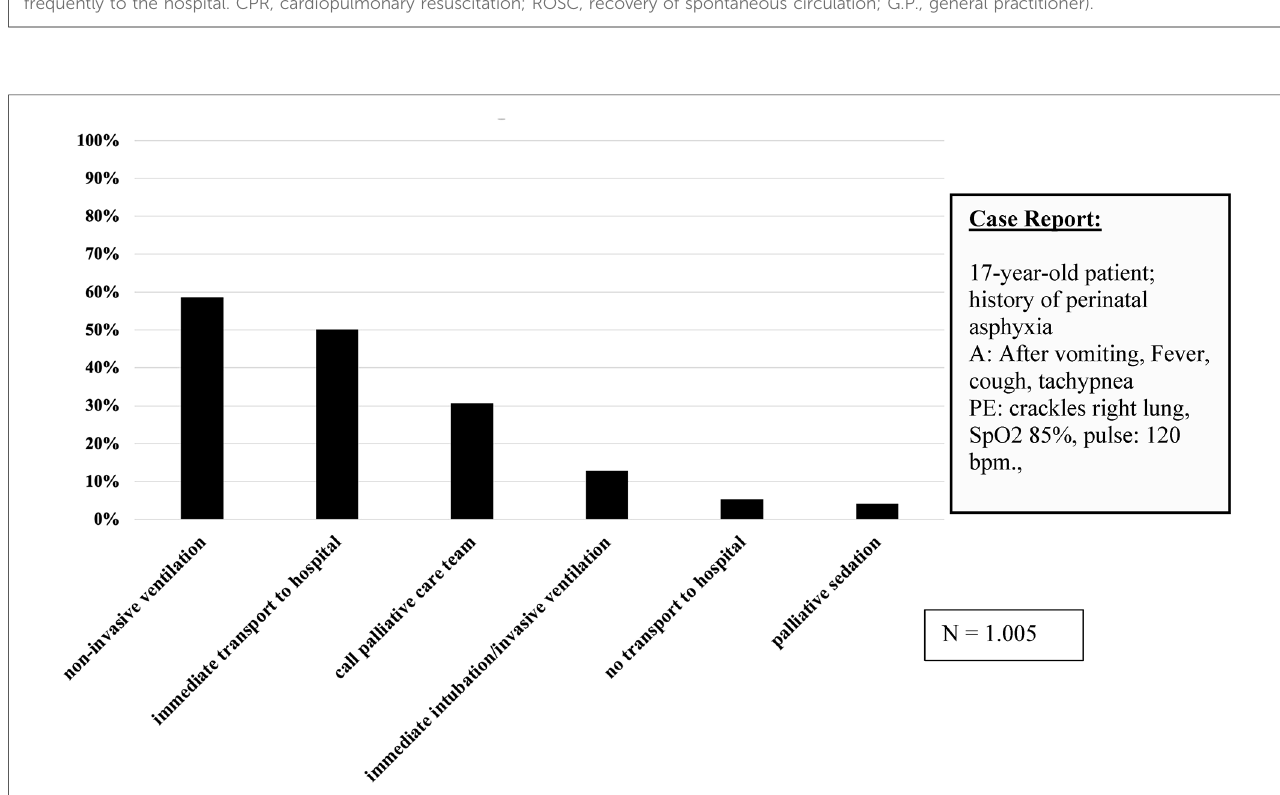
FIGURE 3 First approaches to case report (multiple selections possible). Responding EMT and EMP tended in the case report to non-invasive ventilation and transport to a hospital. A, anamnesis; PE, physical examination; bpm., beats per